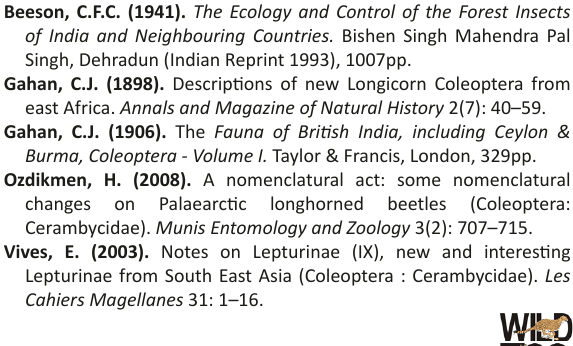
pubescence on various parts.